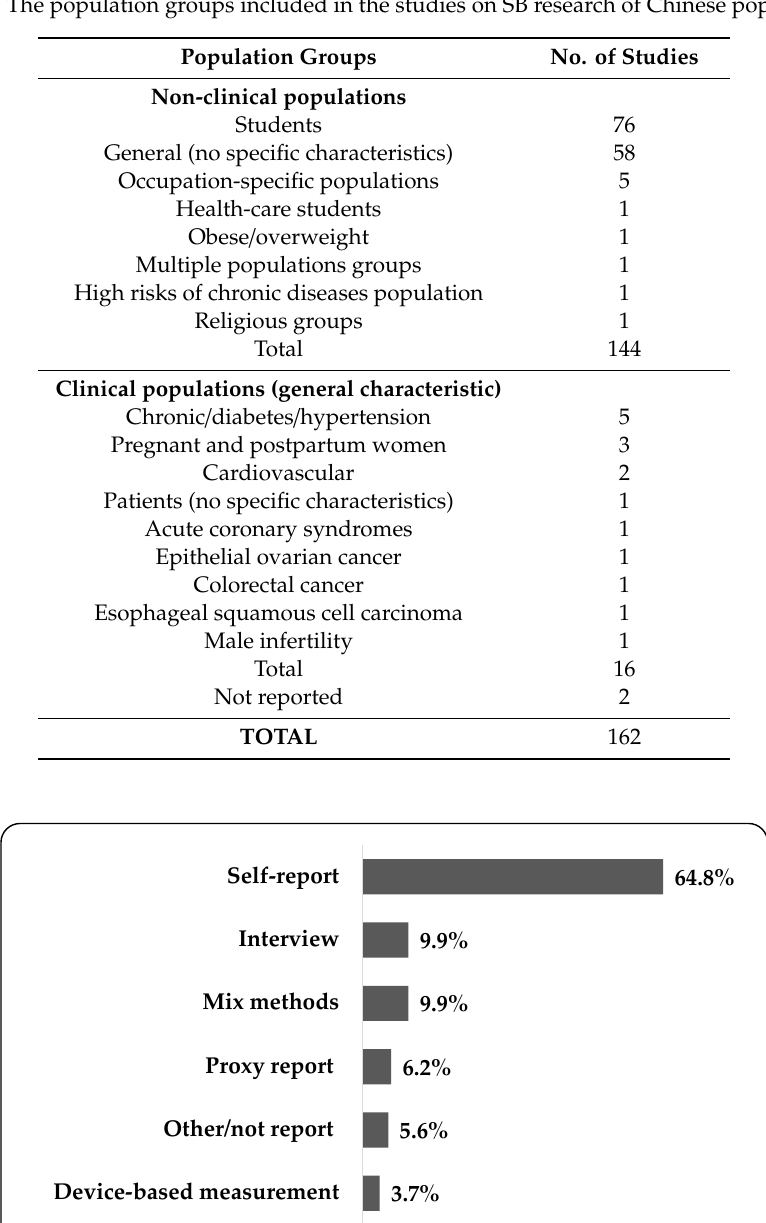
Table 2. The population groups included in the studies on SB research of Chinese population.